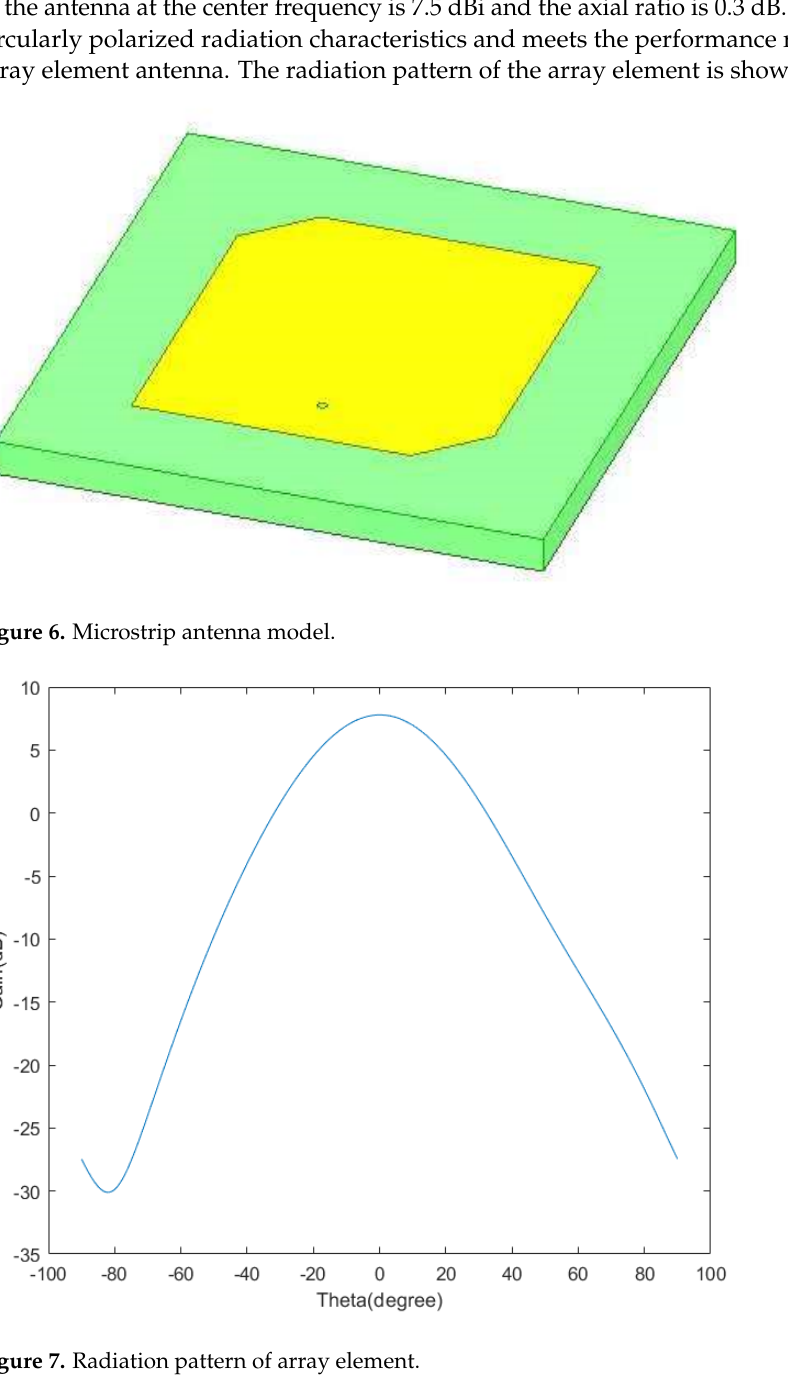
Figure 7. Radiation pattern of array